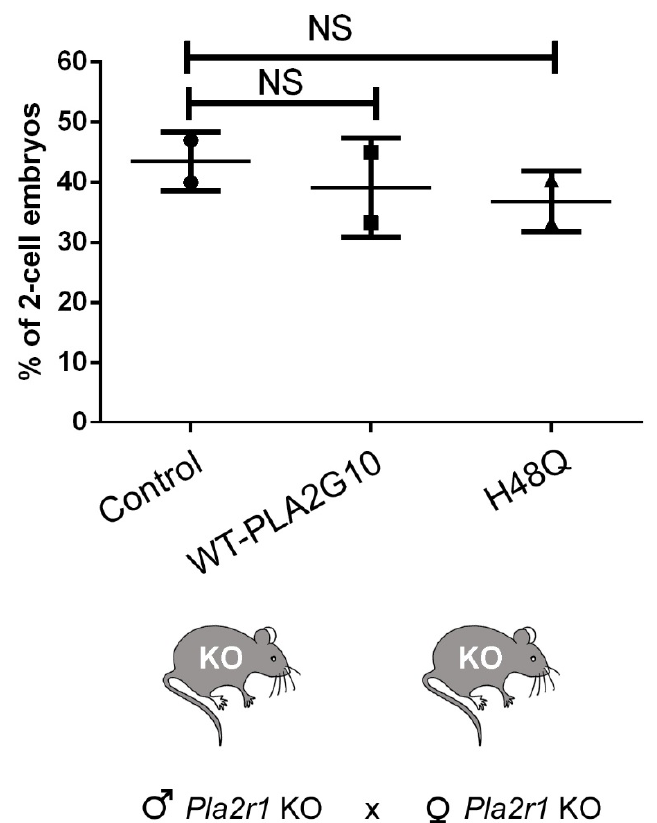
Figure 10. Improvement of fertilization by WT-PLA2G10 and H48Q-PLA2G10 is lost when IVF is performed with sperm and oocytes from Pla2r1 -KO animals. Comparison of the % of two-cell embryos obtained by IVF using WT-PLA2G10 or H48Q-PLA2G10 treated sperm from Pla2r1 -KO males and oocytes from Pla2r1 -KO females (n = 2); no statistical difference (NS).